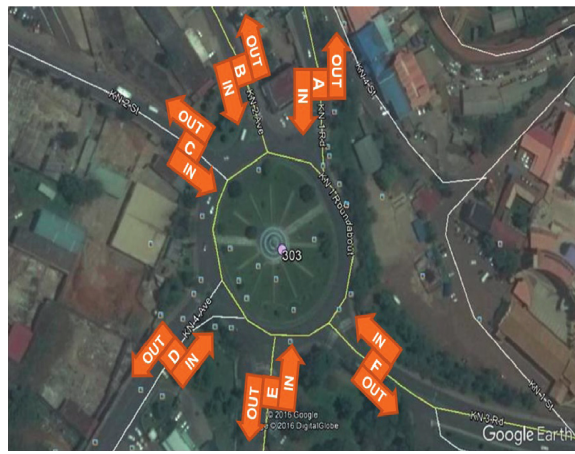
Figure 6: Routes in the case study